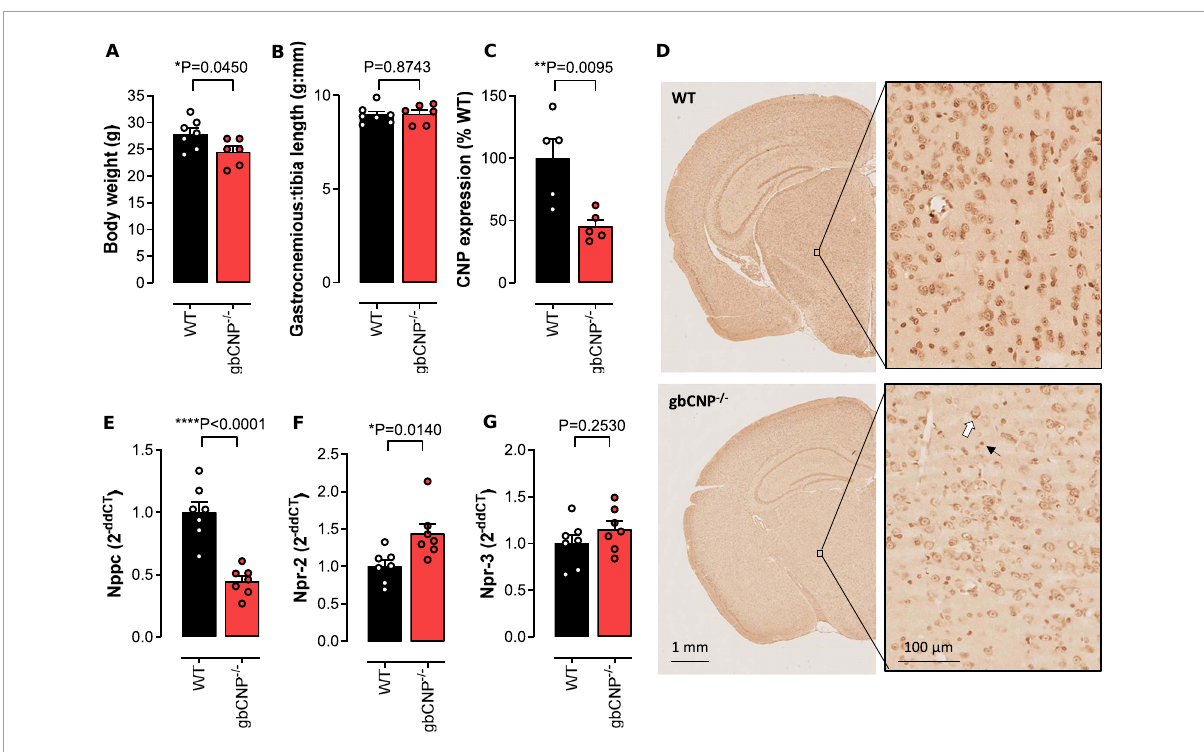
FIGURE1 The effect of CNP deletion on body weight, muscle weight and the expression of CNP and its receptors. Body weight (A) and gastrocnemius weight normalized to tibia length (B) in wild-type (WT) and global CNP knockout (gbCNP - / - ) mice at 12 weeks of age. Densitometric quantification of CNP protein expression using diaminobenzidine (DAB) immunohistochemistry in the brain of WT and gbCNP - / - mice (C) and representative images (D , white arrow indicates neuron and black arrow microglia ) . CNP ( Nppc , E) , NPR-B ( Npr2 , F) and NPR-C ( Npr3 , G) mRNA expression in brain homogenates. n = 5-7. Statistical analysis by two-tailed Student’s t -test. Each statistical comparison undertaken has an assigned P value (adjusted for